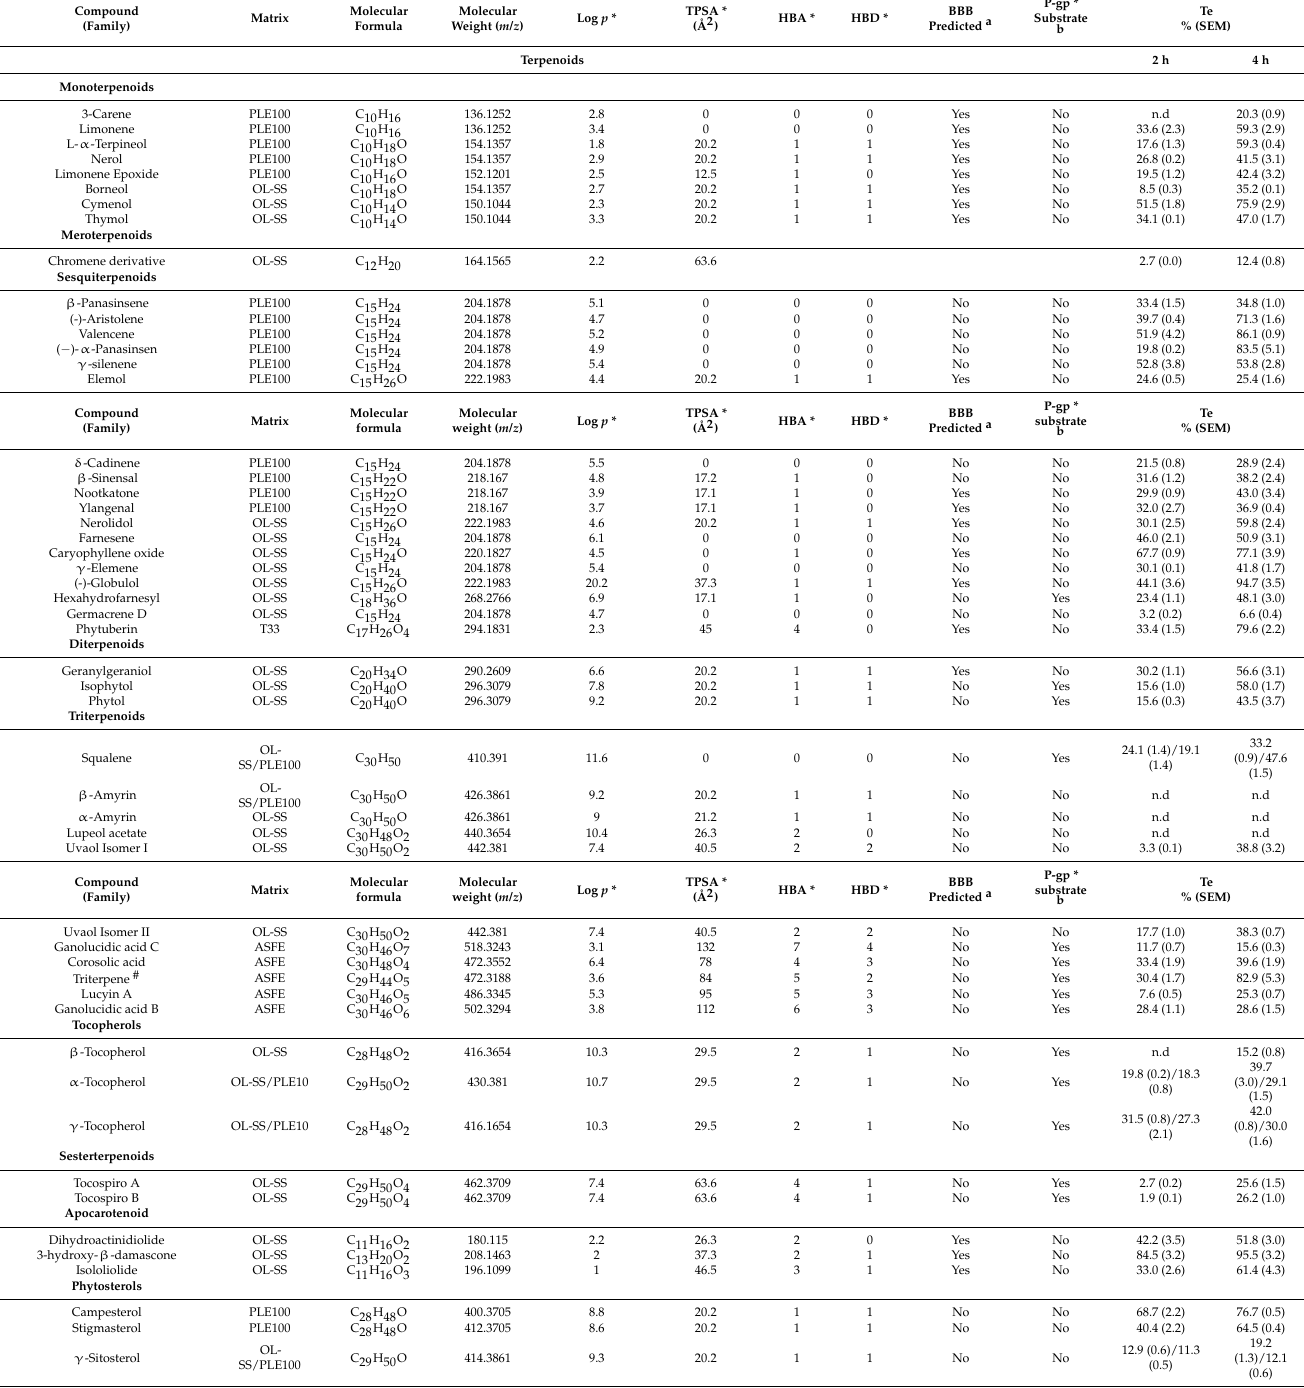
Table 2. Molecular parameters of the bioactive compounds detected and phytochemical profile of the analyzed extracts arranged by families and transport efficiency (Te) after 2 h and 4 h of